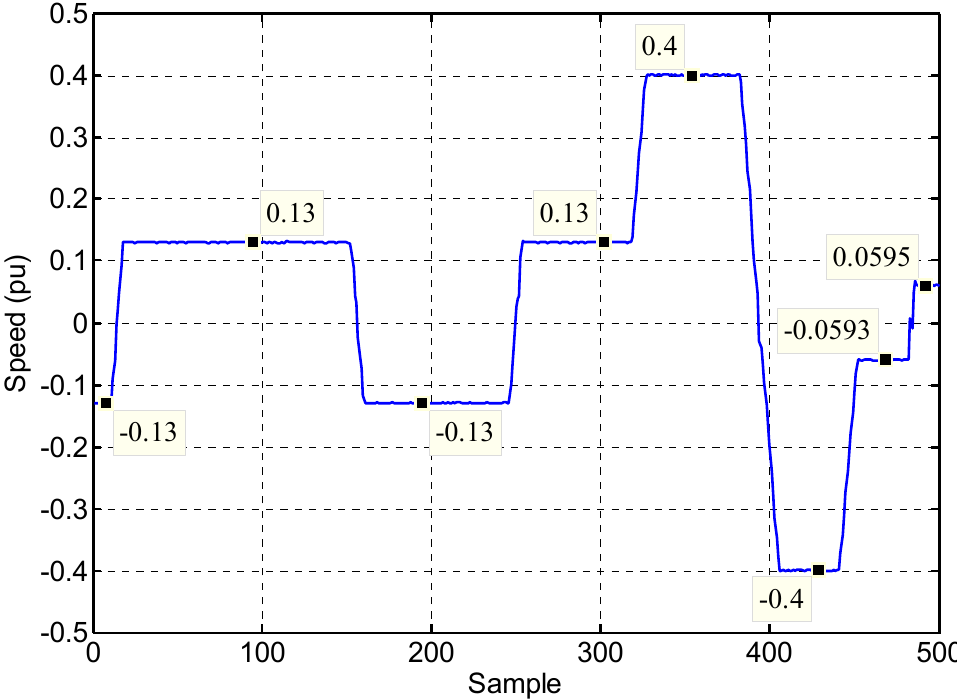
Figure 19. The transient performance of multi-variation in the rotor speed with reversing (The experimental data and measurements have been collected with the aid of the DSP and plotted using Matlab plot tool).